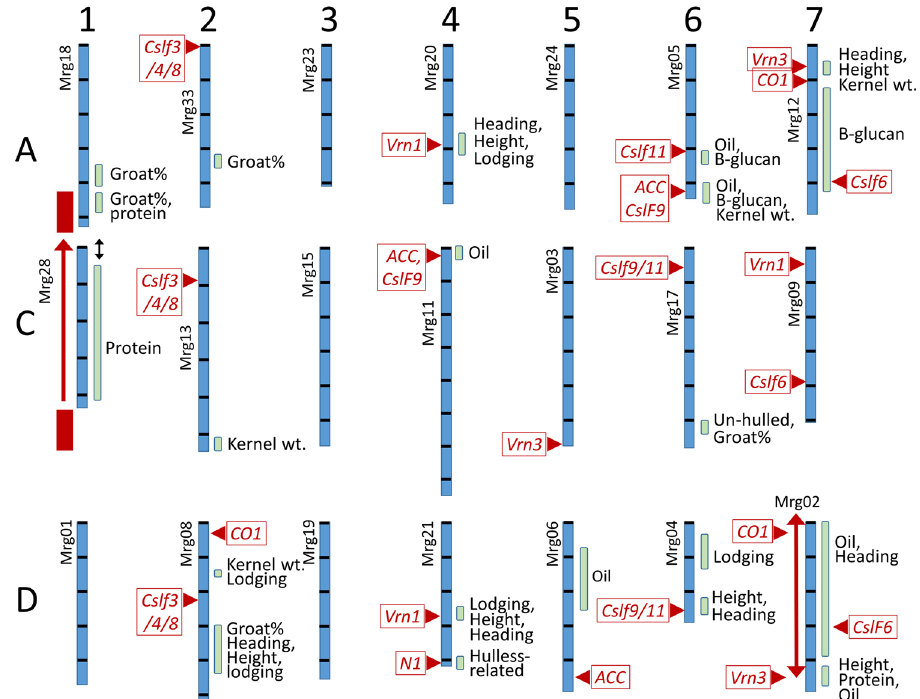
Fig. 2 Positions of major QTL on 21 oat chromosomes relative to candidate genes. Positions and 20% fall-off intervals of major QTLs (LOD >5) affecting trait means across environments in fi ve oat populations (green bars) are shown in relation to positions of potential candidate genes (red boxes with triangles) relative to the Sang reference genome. Black bars show 100 Mbp intervals with base 1 at the top of each chromosome. Consensus linkage group names ( ‘ Mrg ’ identi fi ers) were identi fi ed based on a majority of corresponding markers. QTLs are de fi ned by green bars indicating regions where the test statistic remains within 20% of the LOD peak. Further details and effects of QTL alleles are shown in Table 1 and Supplementary Data 5. Translocation of the region on chr1C (red block) to 1A is indicated by a red arrow (see also Fig. 1) suggesting that the QTLs in these two regions may be the same due to pseudo-linkage between chromosomes (double-headed arrow). Recombination suppression on chr7D, potentially caused by an inversion (red double- headed arrow, see also Fig. 1) results in long parental haplotypes and QTLs that cannot be localized in the cross TxHd.